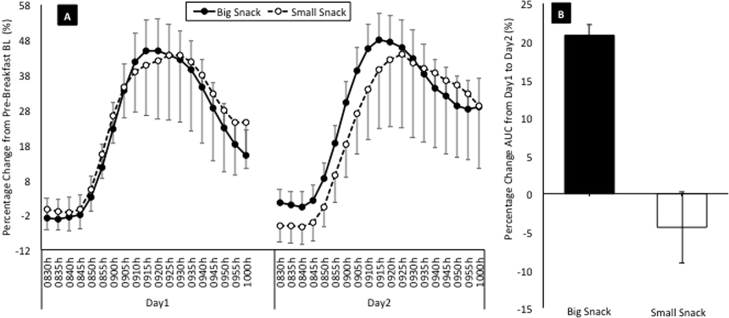
Panel A: Mean glucose data in 5-minute bins for 90 min post-breakfast on Day1 (following a night of sleep) and Day2 (following one simulated night shift) expressed as a percentage change from baseline (BL=average of three pre-breakfast points: 08:15 h, 08:20 h, and 08:25 h, on each day). Open circles represent the small snack group (840 kJ at 00:00 h). Closed circles represent the big snack group (2100 kJ at 00:00 h). Bars represent standard error of the mean. Panel B: Percentage change Area Under the Curve (AUC) from Day1 to Day2 in the big (black column) and small (white column) snack groups. Bars represent standard error of the mean.